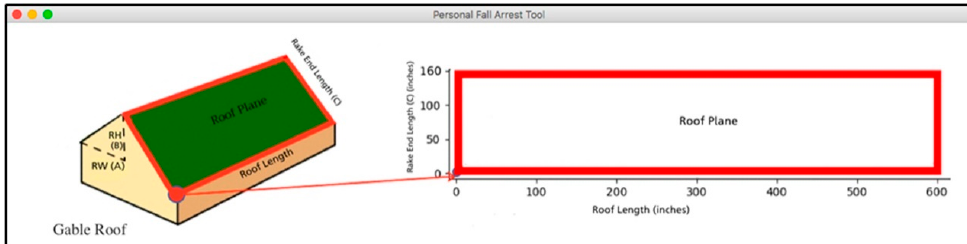
Figure 5. Swing hazard guide (adapted from ANSI/ASSE [14]).